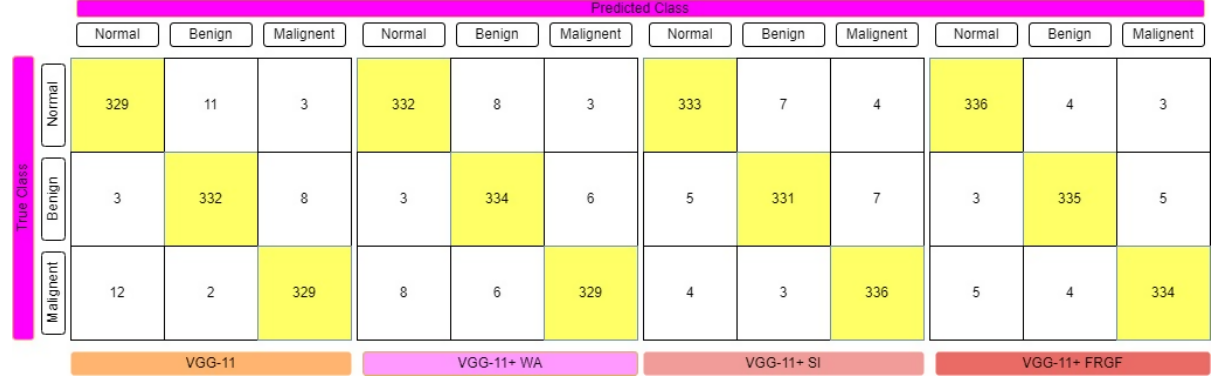
Figure 11. Confusion matrix representation of DenseNet121 deep CNN model with various fuzzy ensemble technologies. DenseNet121, DenseNet121+ WA, DenseNet121+ SI, and DenseNet121+ FRGF showed 96.31%, 96.99%, 97.47%, and 98.35% accuracy, respectively.